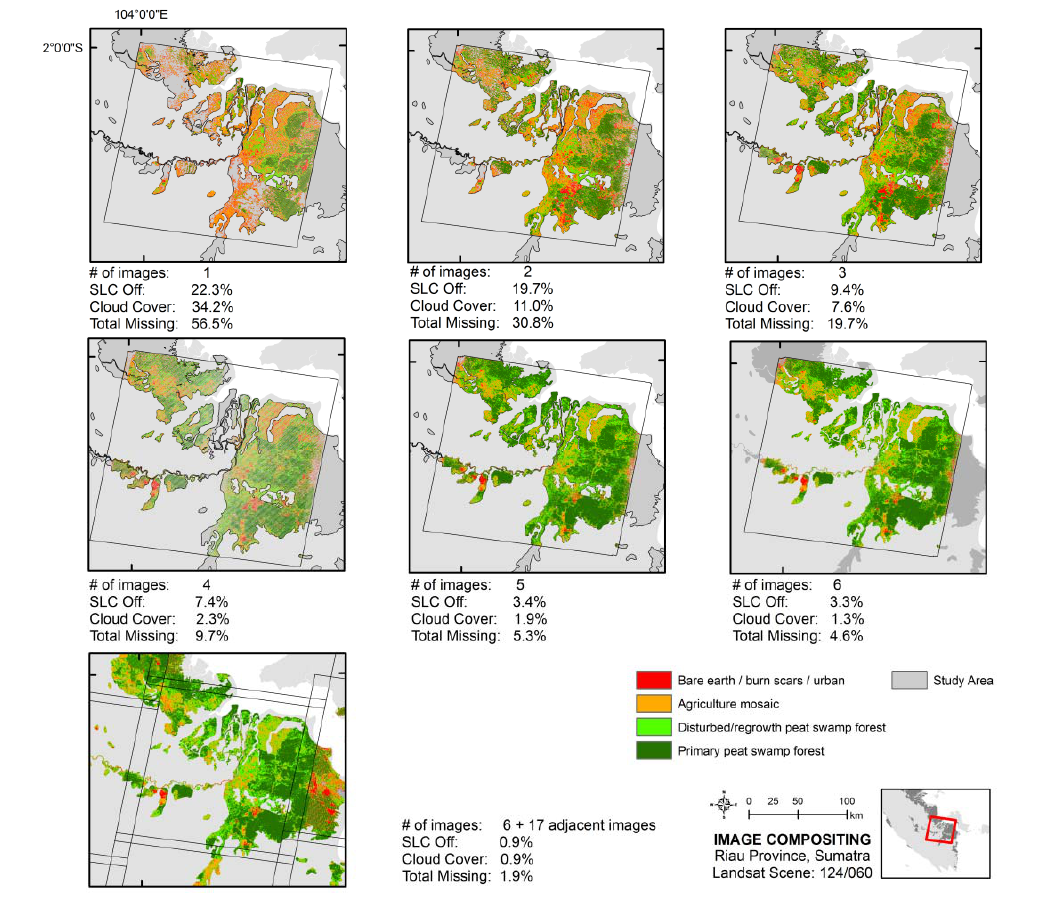
Figure A2. Spatial illustration of missing-data reduction per image when compositing six Landsat-7 SLC-Off images for scene 124/060 of the 2010 composite mosaic. Percentages reported are with respect to the study area, not the entire scene. The mapped area corresponds to Figure